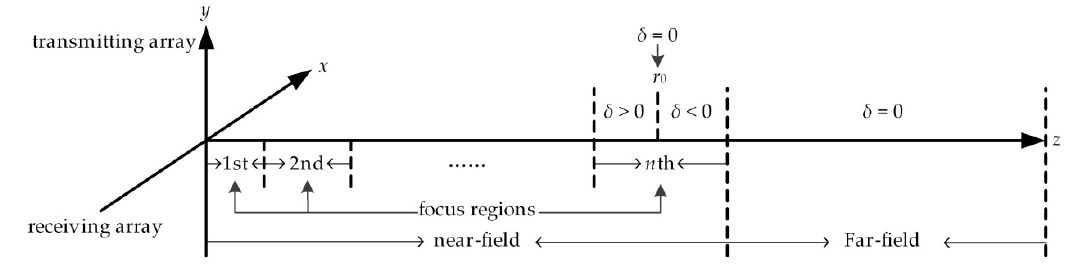
Figure 4. Division of the near-field.